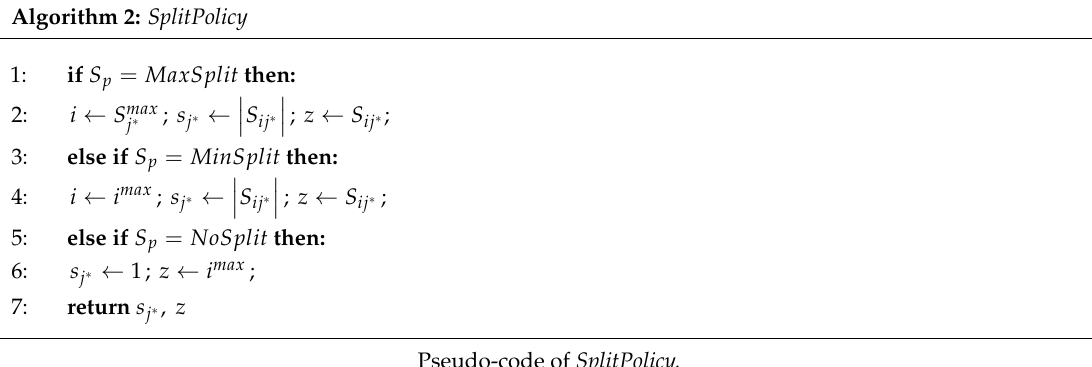
Pseudo-code of SplitPolicy.